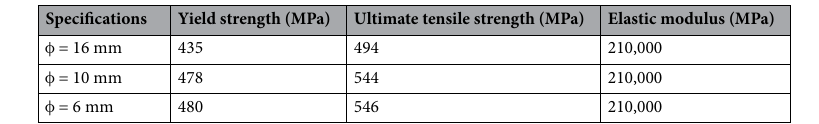
Table 1. Properties of steel